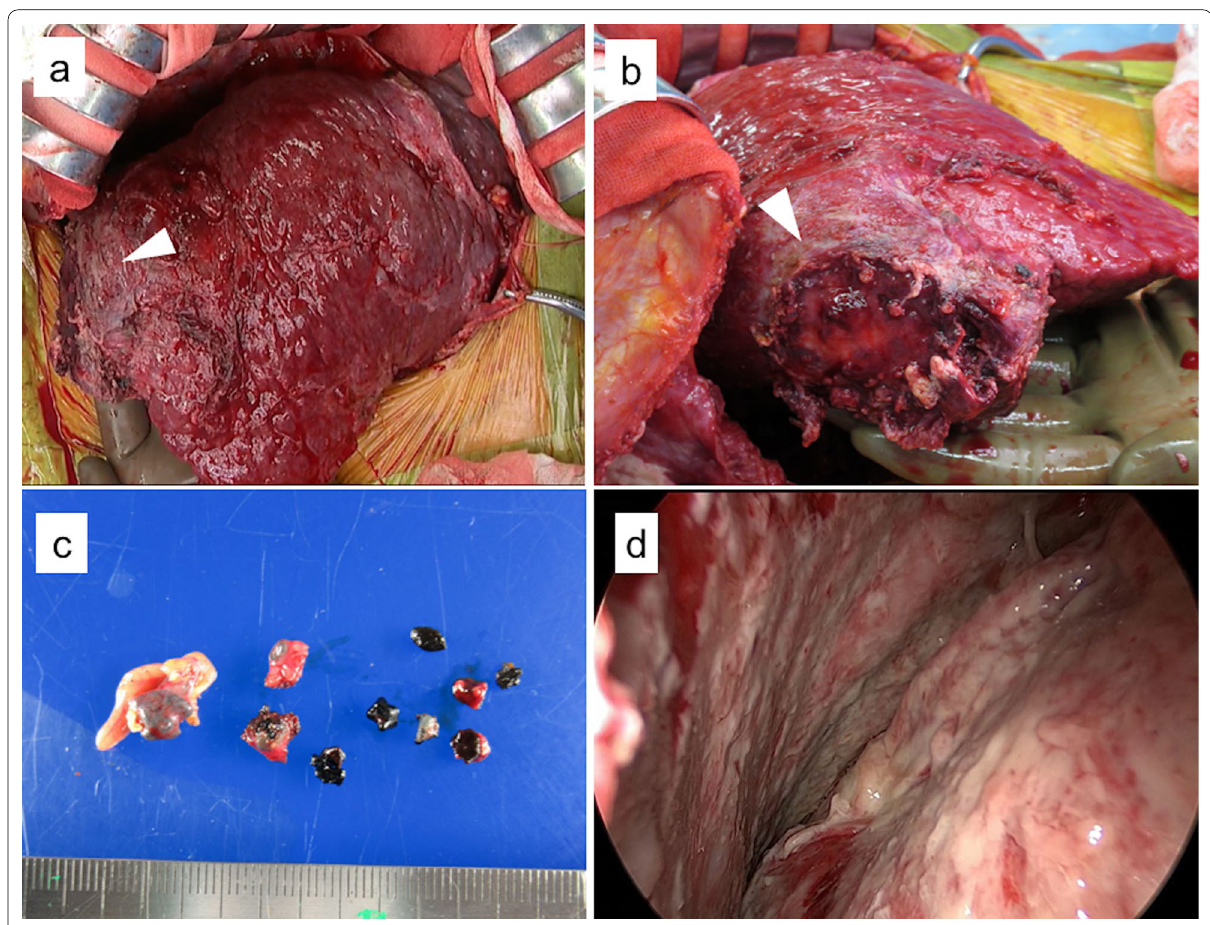
Fig. 3 Thoracotomy and laparotomy for drainage. a , b The abscess in the Morrison’s fossa was opened (arrowhead). c Retrieved gallstones. d Decortication via video-assisted thoracoscopy. No fistula connecting to the abdominal cavity was